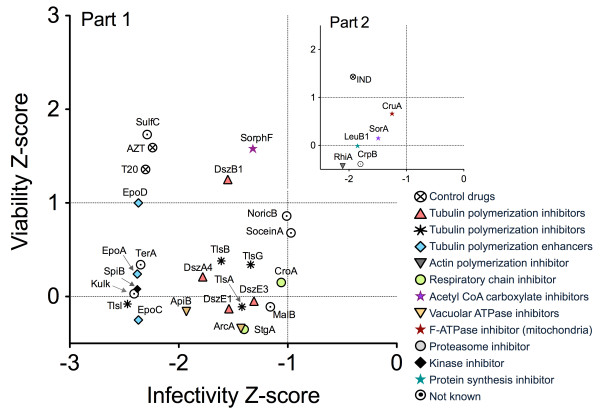
Summary of the strongest myxobacterial hits. The plot shows the viability Z-score vs. the infectivity Z-score of compounds having the strongest antiviral activity (Z score < -1) for both Part 1 and Part 2 (inlay). The figure shows a clear clustering of compounds based on structural similarities and known function (right). The commercial drugs AZT, T20 and IND are included as positive controls. Compounds are abbreviated to prevent figure congestion. Corresponding compound names are given in Table 1.